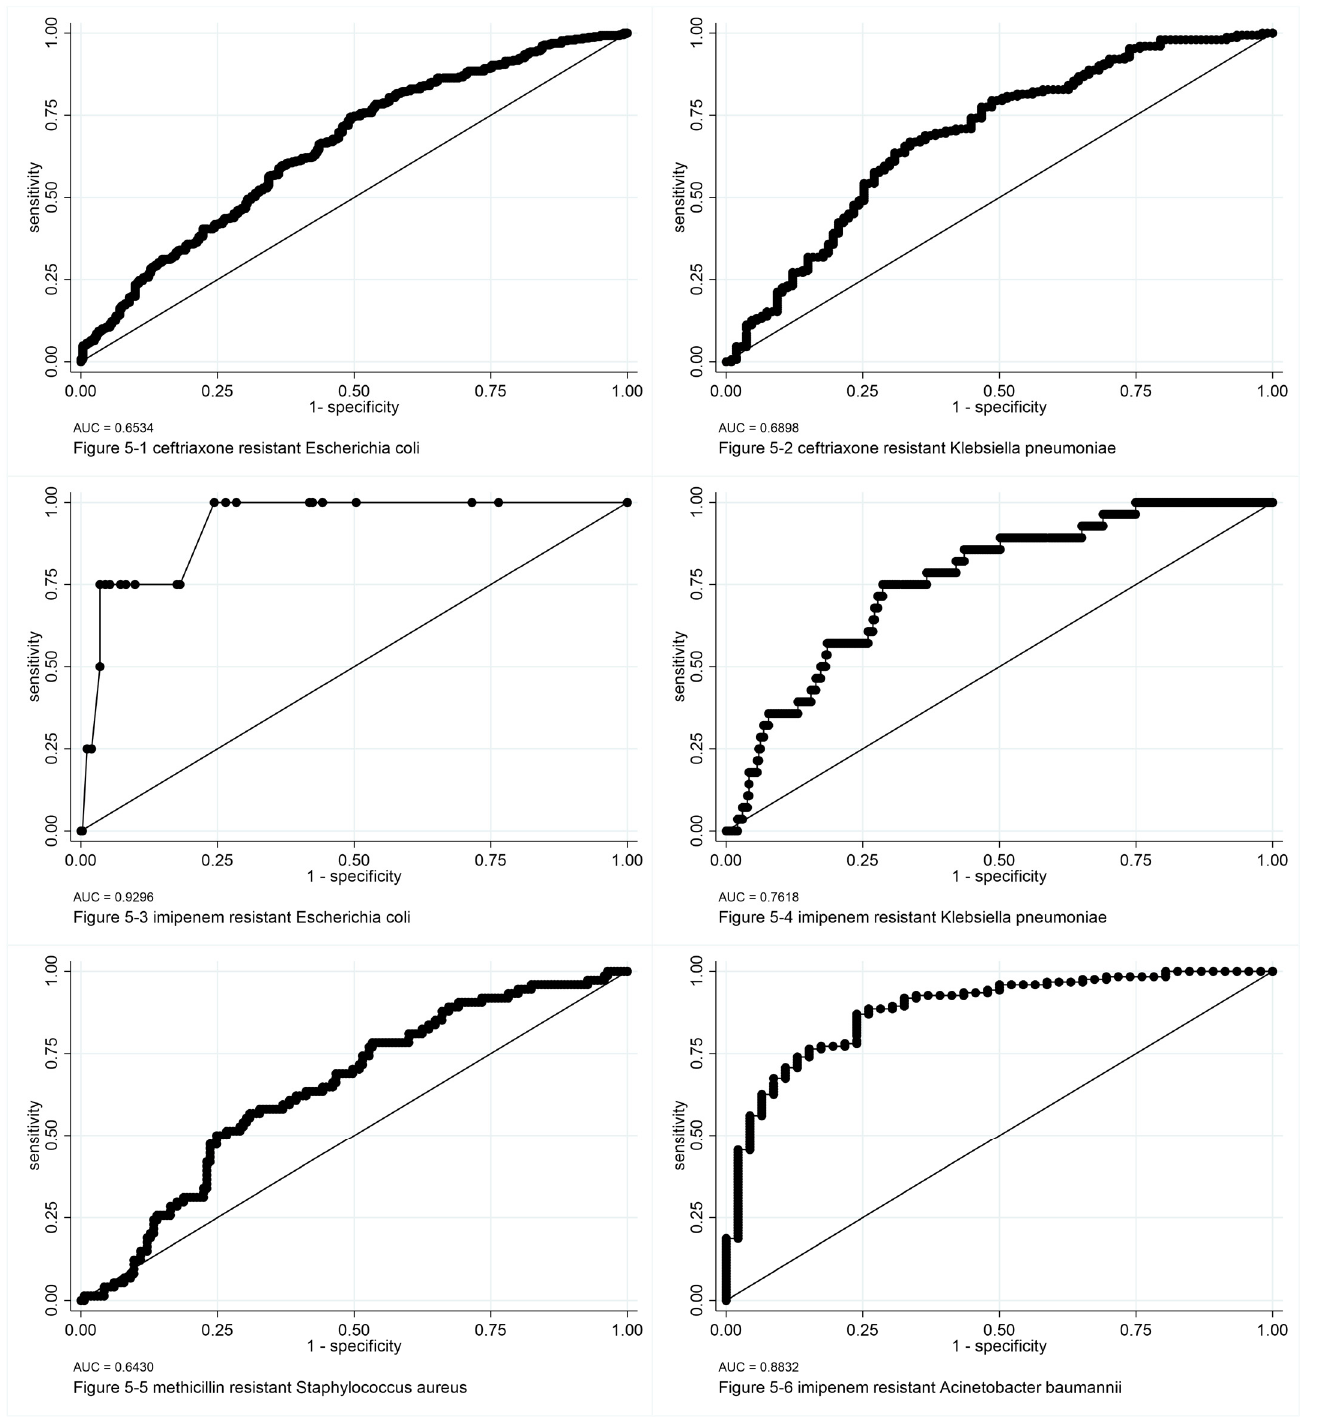
Figure 5. ROC curves of logit models of bacterial bloodstream infection analysis. ROC: receiving operator characteristic, AUC: area under the ROC curve.